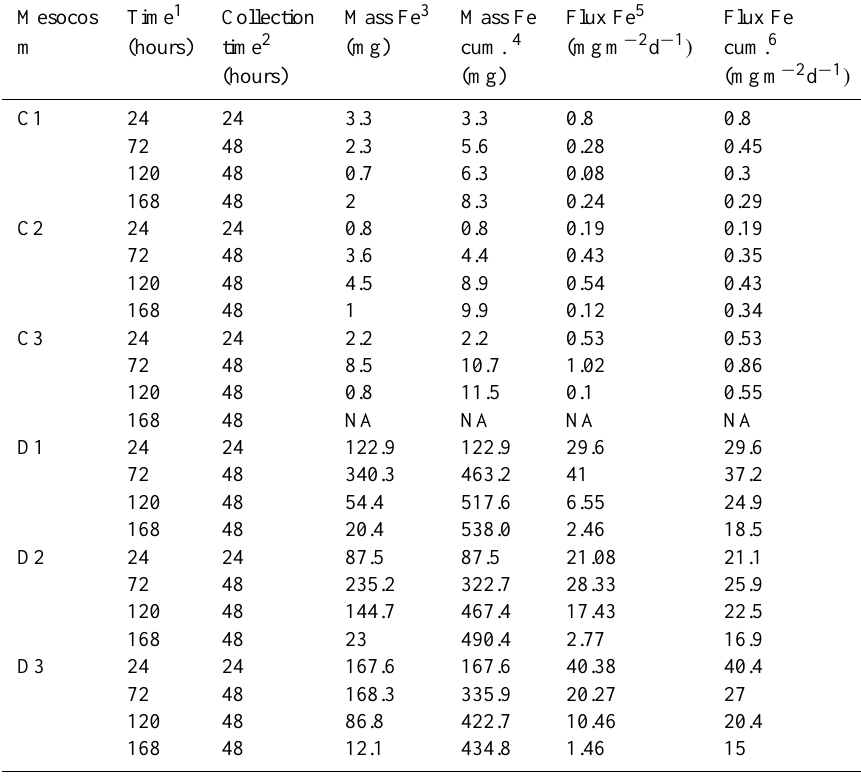
Table 1. Fe masses and fluxes exported to the sediment traps during the DUNE-1-P experiment.